Question: Which visualization type does this figure use?
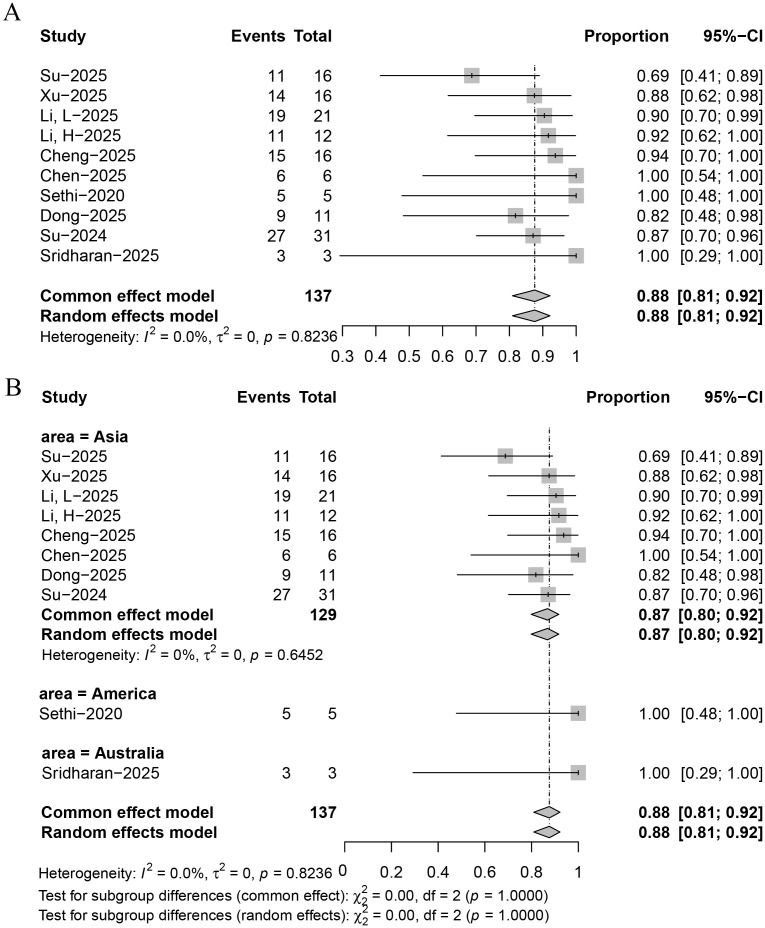
Answer: forest